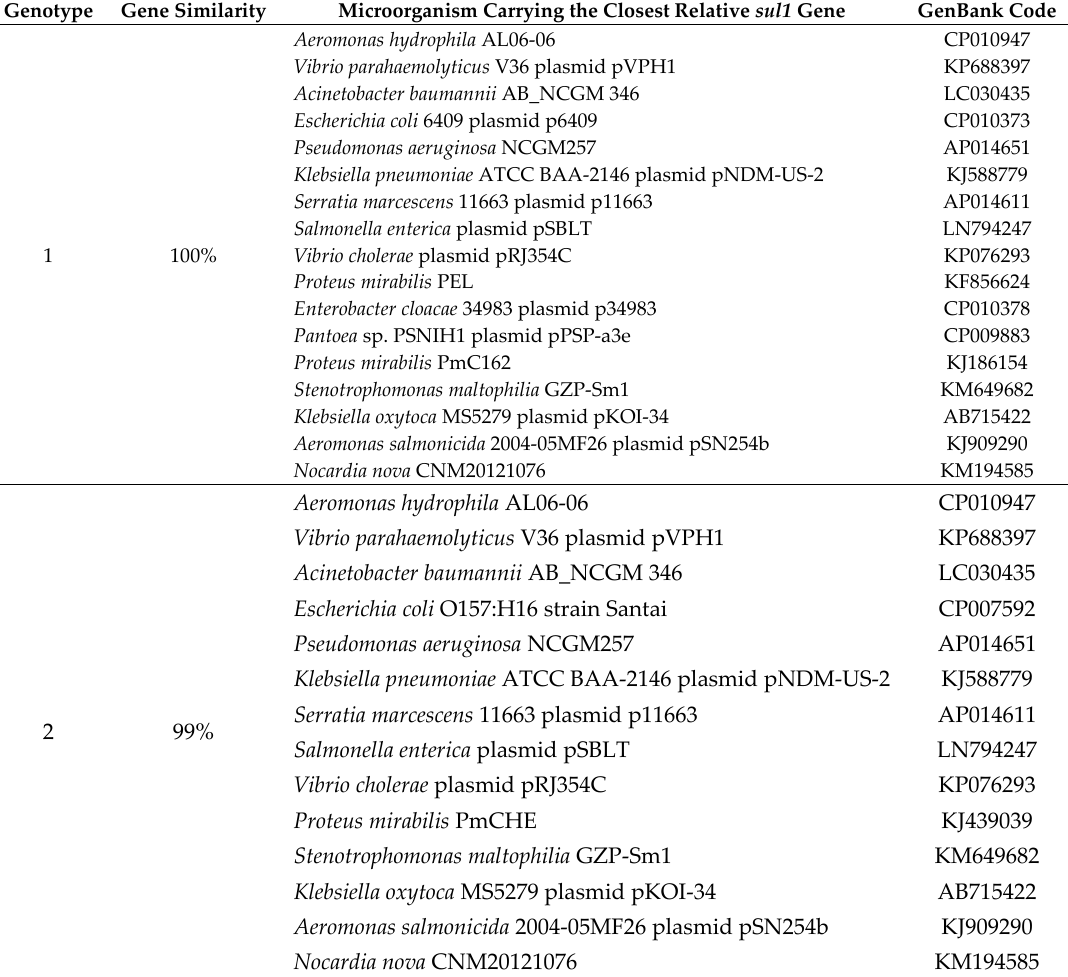
Table 3. Identification of the major sul1 genotypes in the WWTP